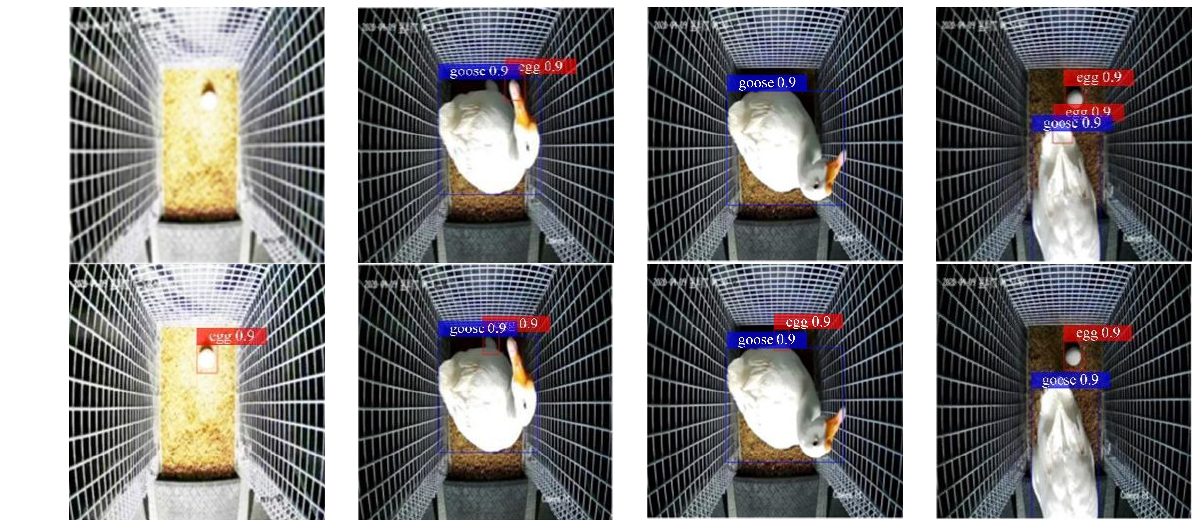
Figure 10. Some effects of the two algorithms on target recognition: ( a ) traditional SSD; ( b ) improved SSD. Table 2. Detection results of breeding geese and goose eggs.